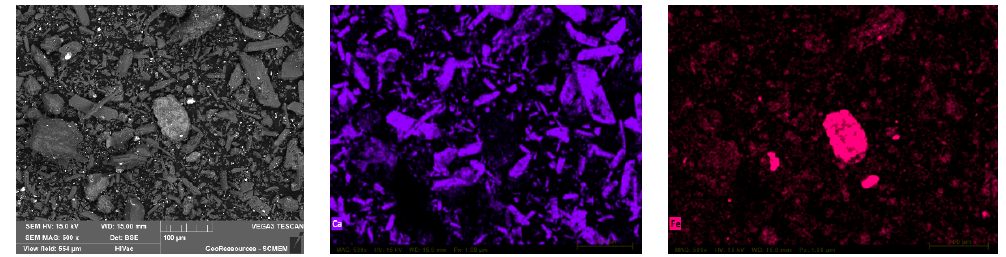
Figure 3. SEM image with over laid EDS mapping of leach residue obtained after of Ni-Cd cake waste residue with mixture of hydrochloric acid and sulfuric acid.